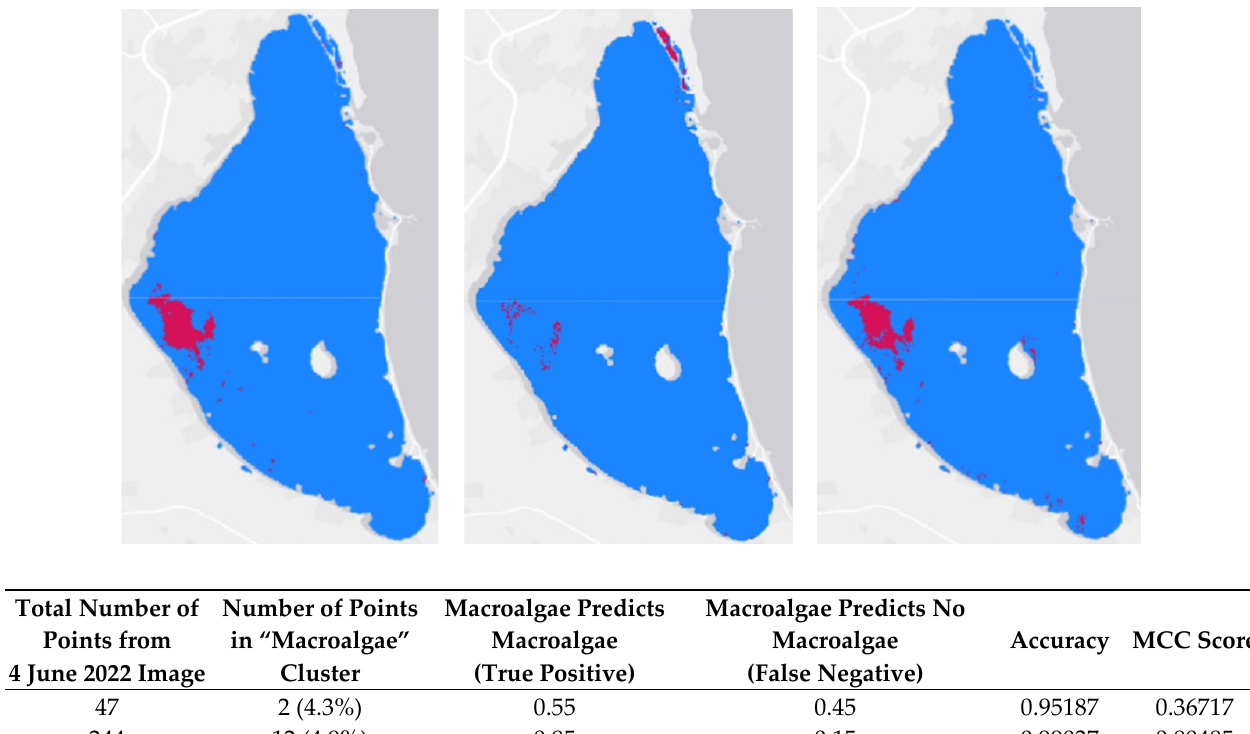
Figure 8. “Macroalgae-no macroalgae” original clusters on 4 June 2022 ( left panel, highlighted); results of classification on image from 4 June 2022 including 47 random points from new image in training ( center panel); results of classification on image from 4 June 2022 including 244 random points from new image in training ( right panel). Bottom: summary of metrics for 4 June 2022 image as evaluation image, including a given number of pixels from that image together with 5000 pixels from each of the images from 25 April 2022, 10 May 2022, and 25 May 2022. “True negatives” and “False positives” are above 0.99 and below 0.01, respectively, in all cases and have not been included in the table.